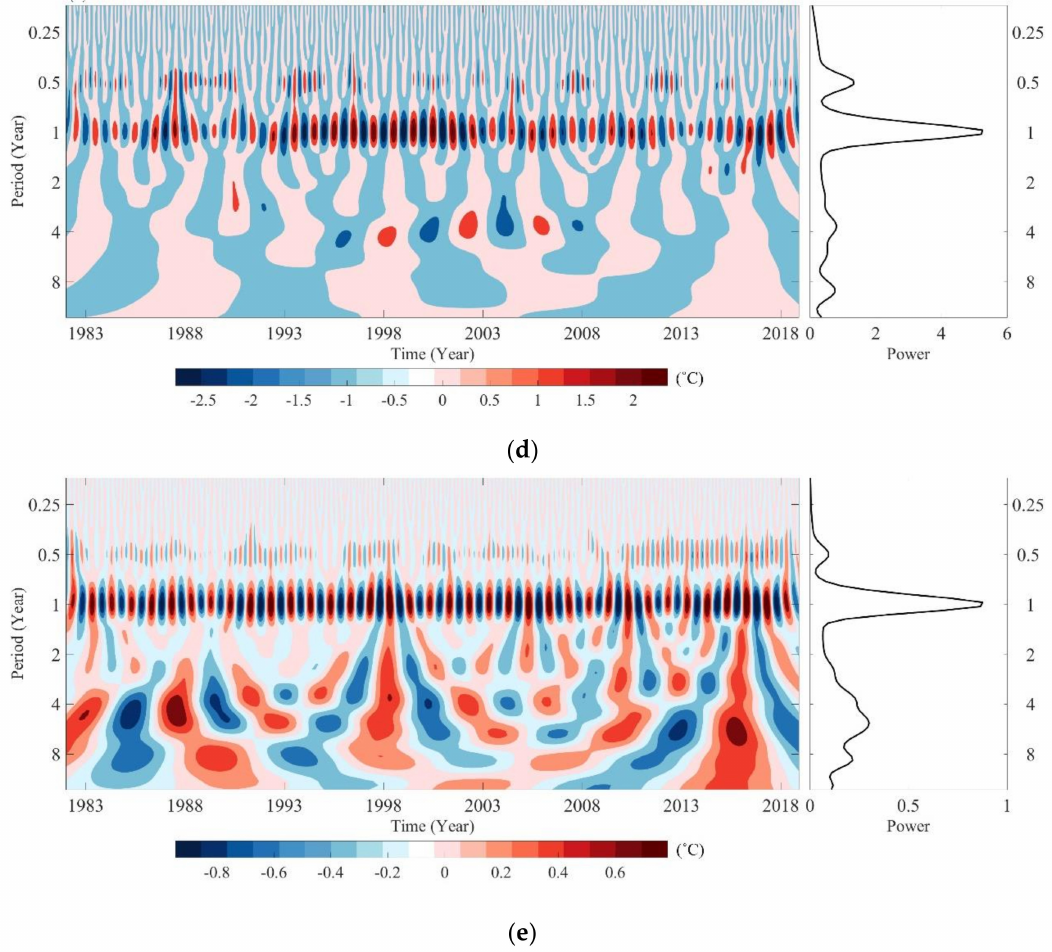
Figure 7. Wavelet transform spectrum and corresponding mean power of ( a ) Size variation; ( b ) Zonal center movement; ( c ) Meridional center movement; ( d ) Maximum SST; ( e ) Mean SST of the IW.